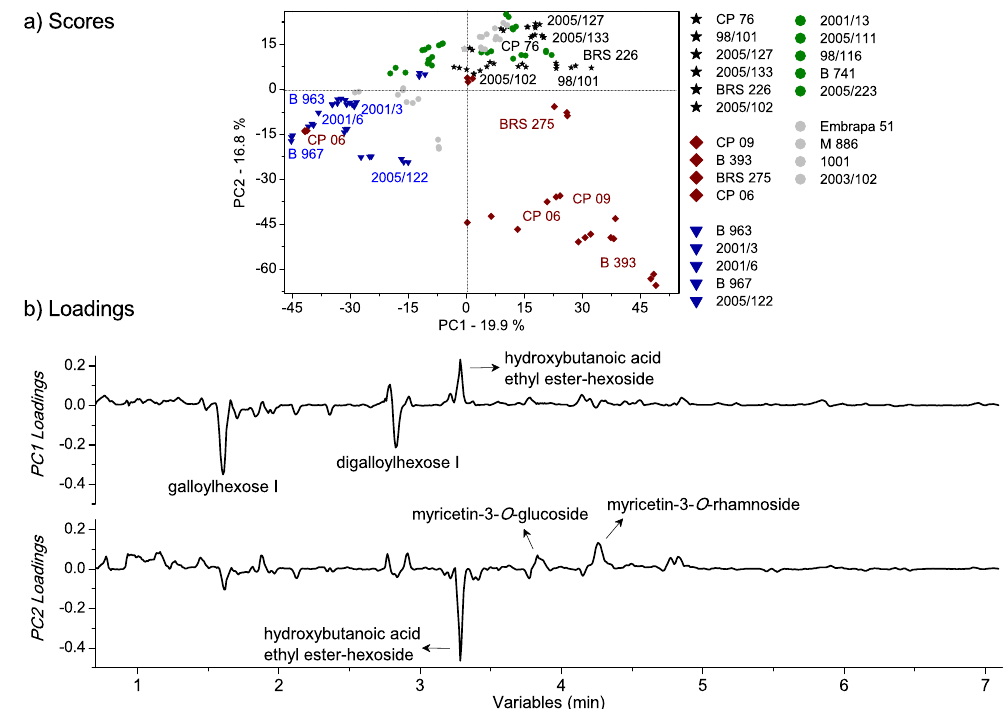
Figure 3. Principal component analysis (PCA) multivariate analysis of UPLC-HRMS data from cashew apple pulps of different genotypes: a) PC1 × PC2 scores coordinate system for the cashew apple pulps from different genotypes; b) respective loadings plotted in lines form. The samples were assigned symbols according to the clustering tendency: blue triangles for negative values of PC1 and PC2; red squares for positive values of PC1 and negative values of PC2; black stars for positive values of PC1 and PC2; green circles for positive values of PC2. The samples that did not present relevant results were symbolized by gray circles.